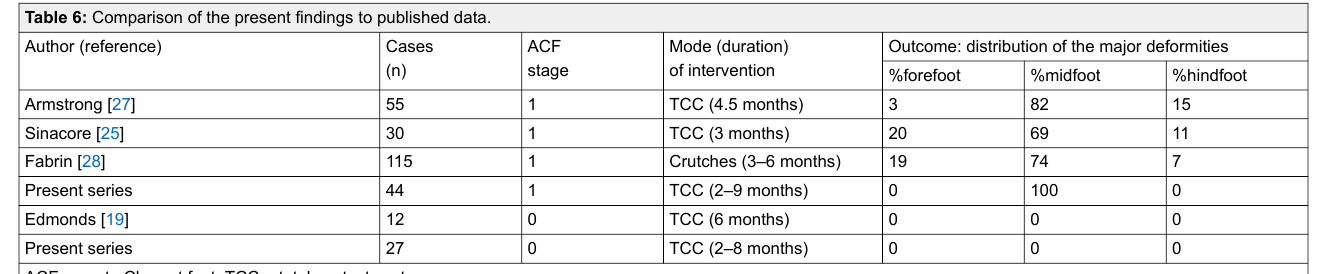
Table 6: Comparison of the present findings to published